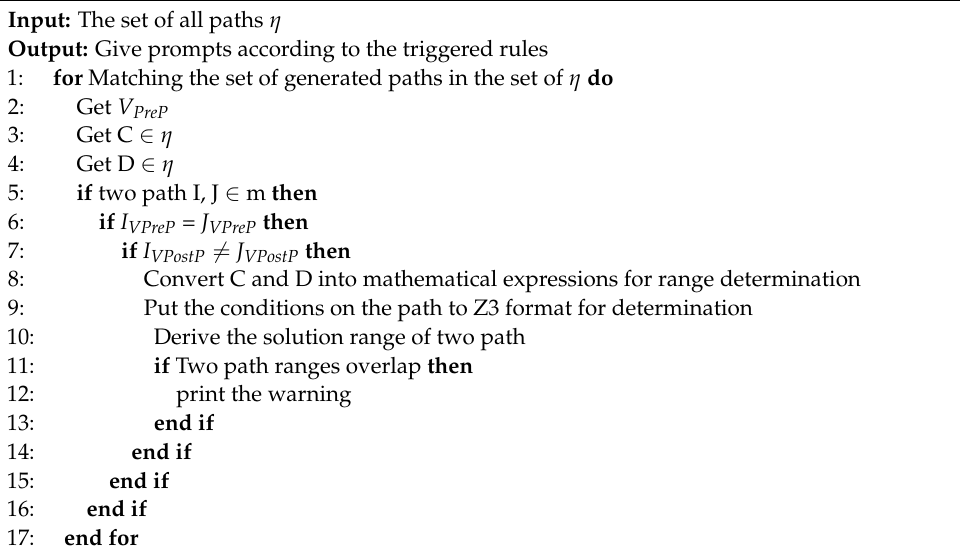
Algorithm 2: Functional scenario condition